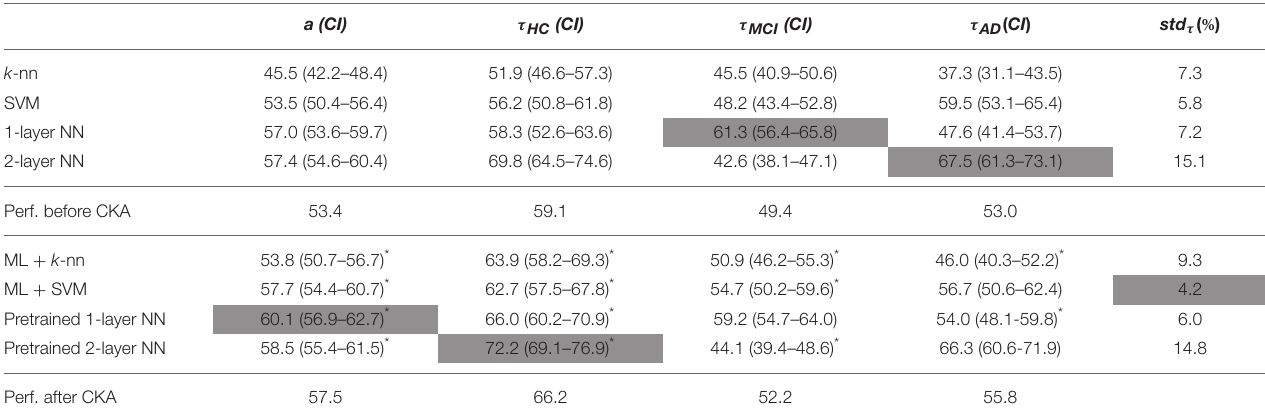
TABLE 3 | Testing performance of the metric learning for the multi-class